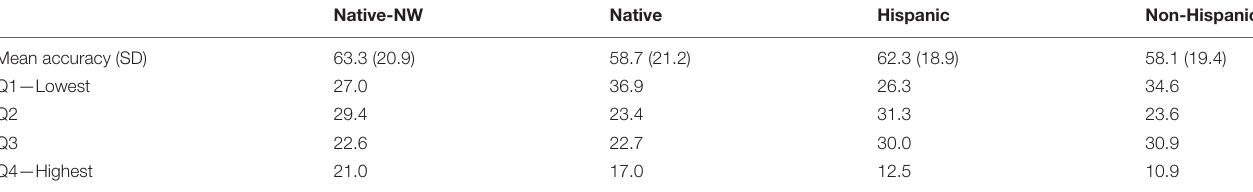
TABLE A3 | Reading comprehension accuracy and percent quartile